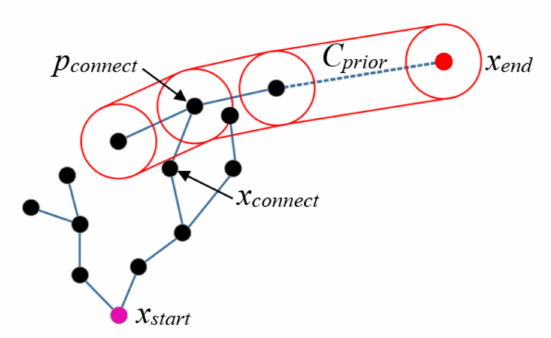
Figure 5. Connection nodes.